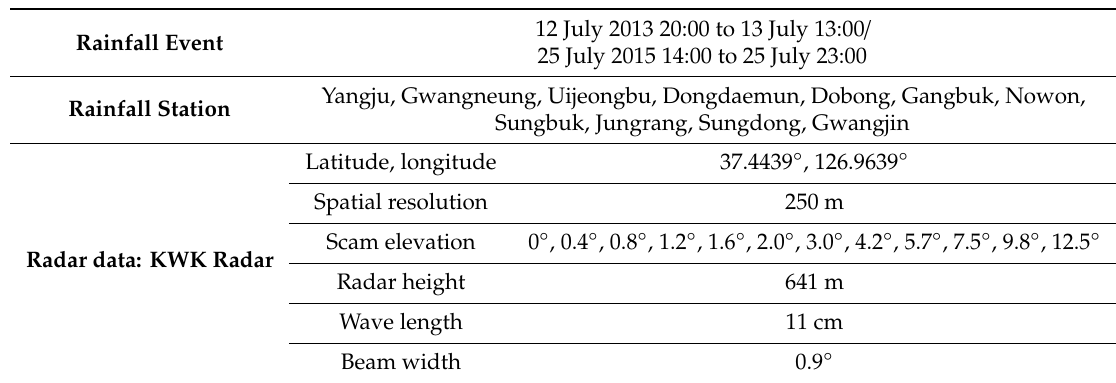
Table 1. Rainfall events and characteristics of radar data.